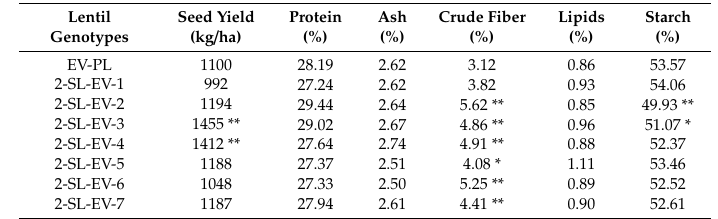
Table 5. Seed yield and nutritional quality traits of the parental landrace “Evros” (EV-PL) and second-generation sister lines originating from “Evros”.